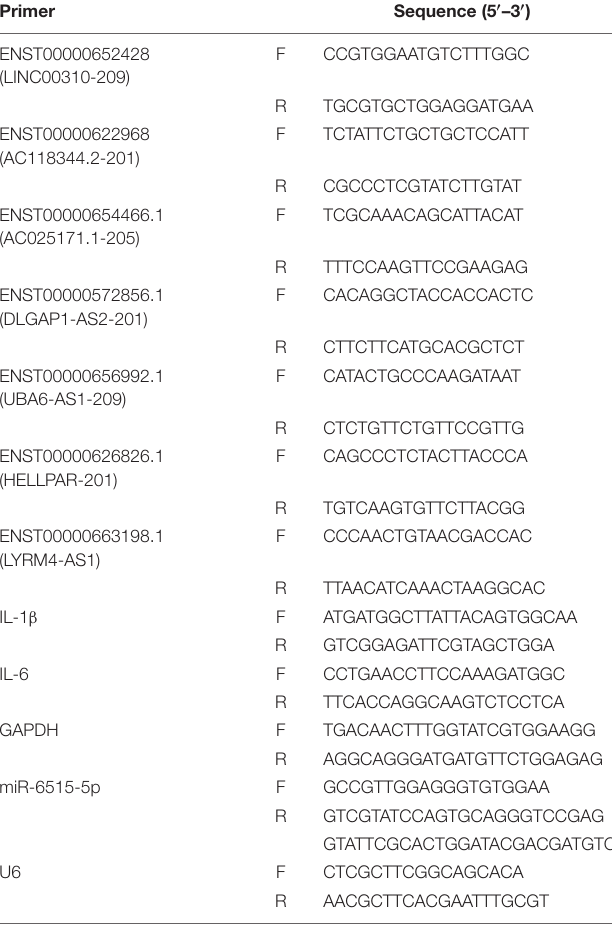
TABLE 1 | The sequences of all primers.